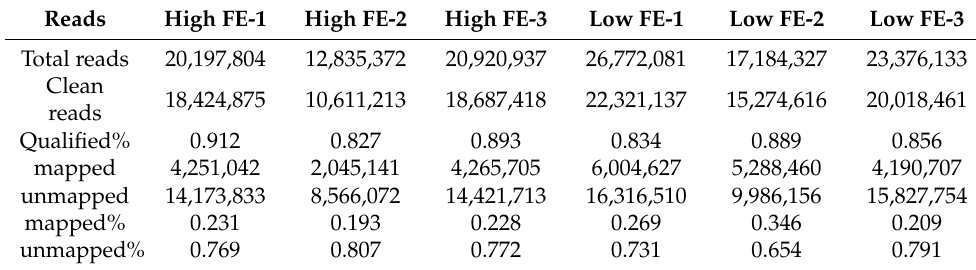
Table 2. Summary of miRNA-seq